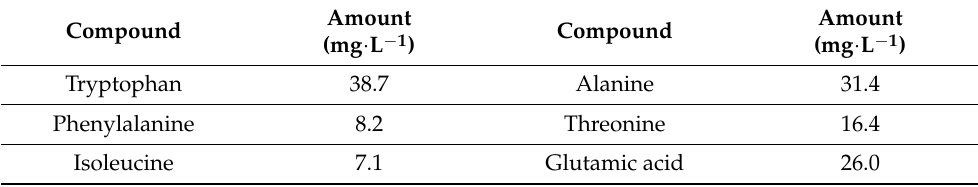
Table A2. Free amino acid and ammonium chloride concentrations in a modified synthetic